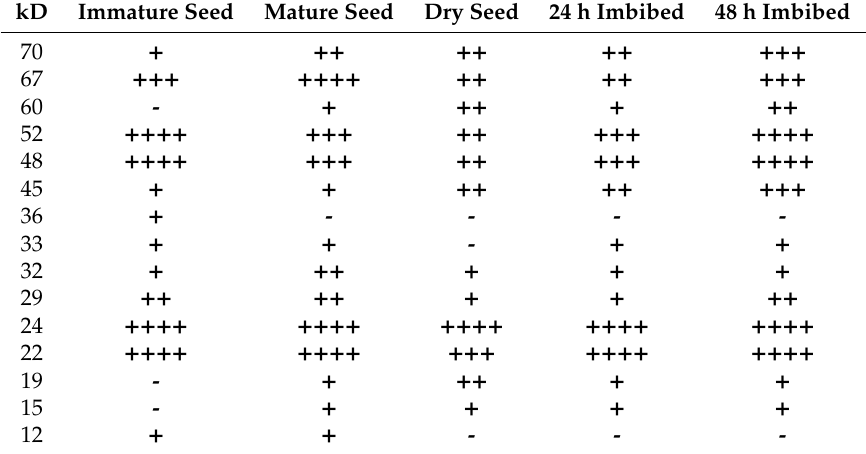
Table 1. Molecular weight and relative abundance of seed membrane proteins. Gel band staining ranked per lane in quartiles of intensity indicated as ++++ > +++ > ++ > + and not detected (-). kD Immature Seed Mature Seed